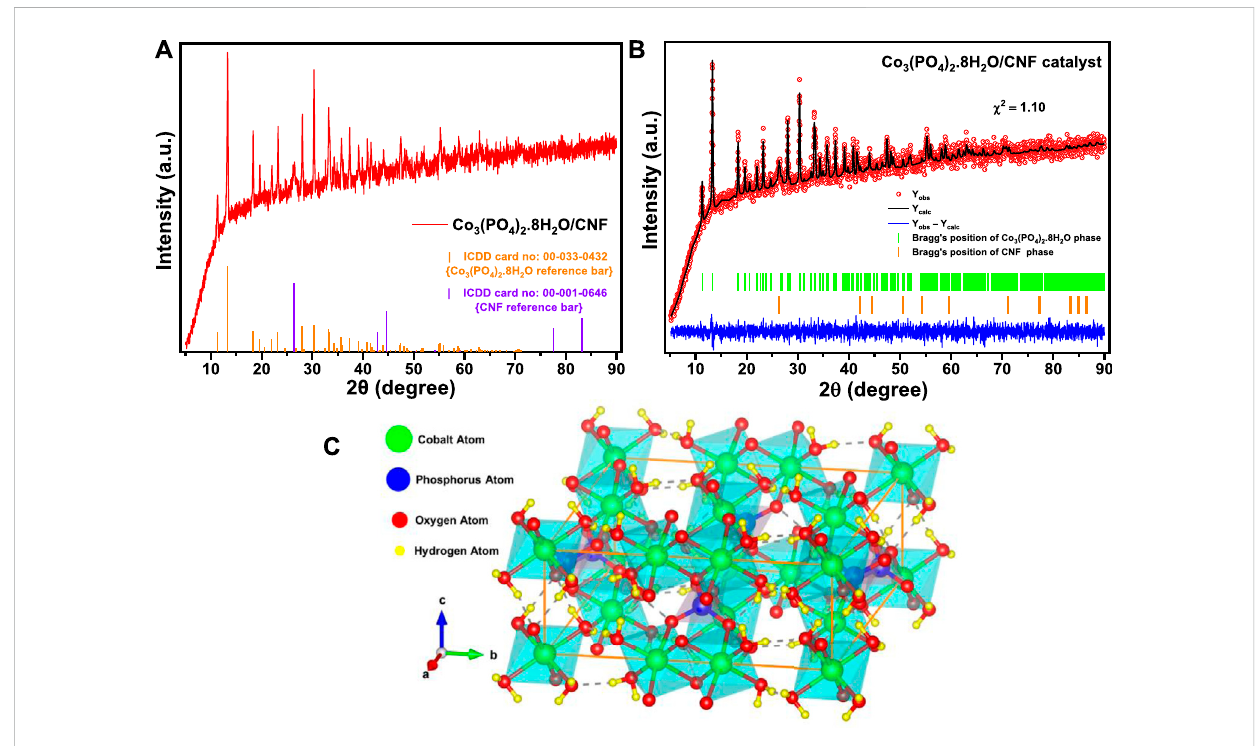
FIGURE 2 (A) XRD pattern of the Co 3 (PO 4 ) 2 .8H 2 O/CNF catalyst, (B) Rietveld-re fi ned XRD pattern of the Co 3 (PO 4 ) 2 .8H 2 O/CNF catalyst, and (C) VESTA- generated polyhedral ball – stick model crystal structure of the monoclinic crystal lattice of the Co 3 (PO 4 ) 2 .8H 2 O phase with unit cell volume 603.095581 Å 3 (drawn with solid orange lines), where a = 10.02100 Å, b = 13.32390 Å, c = 4.67245 Å, α = γ = 90 ° , and β = 104.8240 ° .